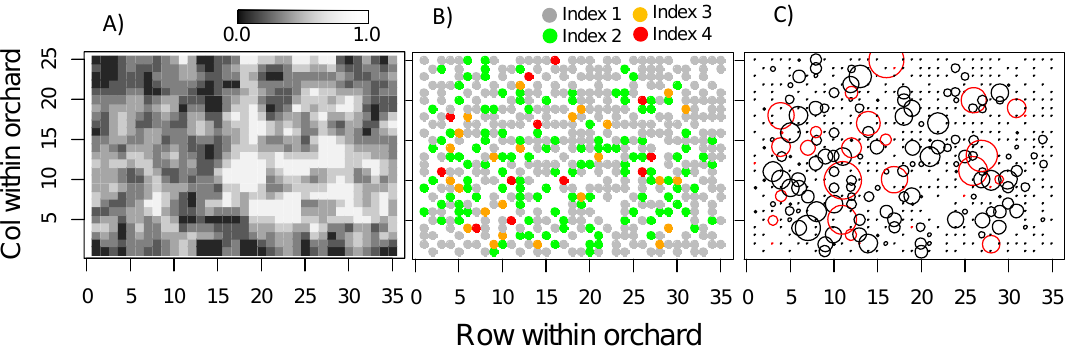
Figure 1. Within the orchard, spatial variation in ( A ) relative photosynthetic photon flux density. ( B ) Fruiting index of each tree. Index 1: trees that did not produce female cones, index 2: trees with female cones that were very sparsely distributed within the crown, index 3: trees with female cones that were sparsely distributed within the crown, or trees produced numerous female cones on a few branches only and index 4: trees that produced female cones abundantly on several branches. ( C ) Number of female cones produced per tree. Red circles indicate girdled trees and black circles indicate intact trees.